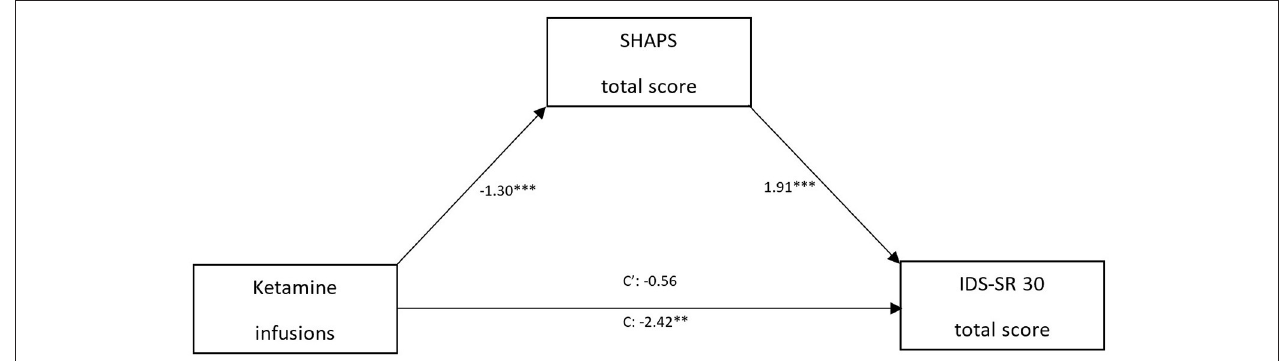
FIGURE 4 | The mediating effect of anhedonia in the relationship between ketamine treatment and the 30-item Inventory for Depressive Symptomatology—Self Report (IDS-SR 30) score. Snaith–Hamilton Pleasure Scale (SHAPS). # The model presents unstandardized